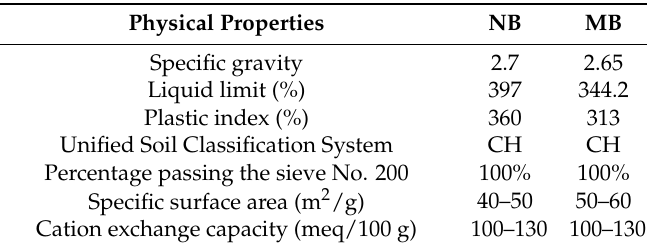
Table 1. Physical properties of NB (Nature sodium bentonite) and MB (Modified bentonite) as used in this study.